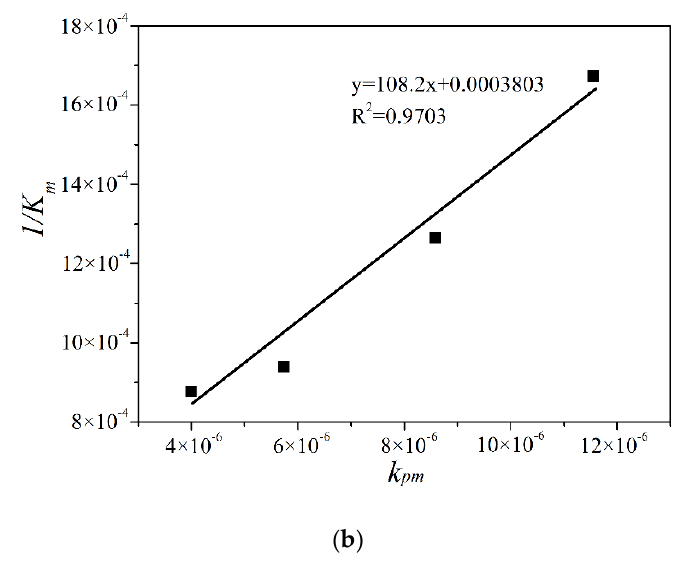
Figure 4. The relationship of the kinetic parameters in modified L-H model ( a ) The linear of ln( c 0 / c )/( c 0 − c ) vs. t /( c 0 − c ), ( b ) The linear of 1/ K m vs. k pm (solid points: experimental results; solid line(curve): Fitted results). Table 2. Results of modified L-H model under different illumination intensity.